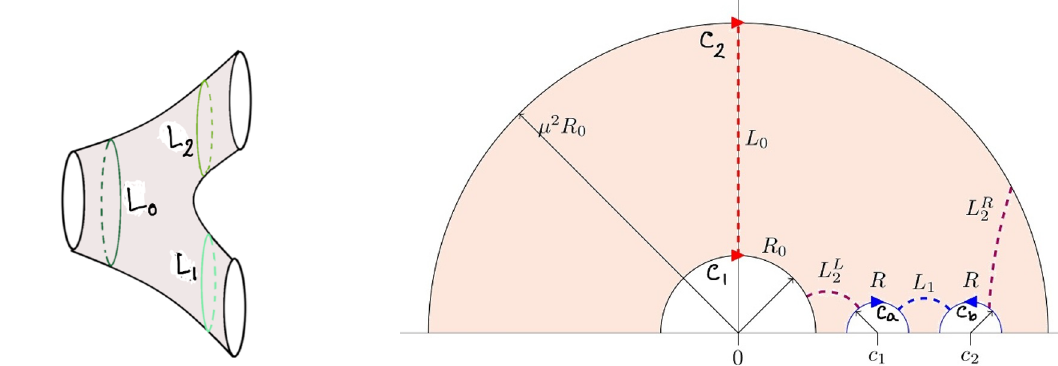
Figure 1. Pair of Pants and Polygonal Representation. In the figure, concentric geodesic edges are denoted by C and C , whereas C and C stand for geodesics that are not concentric. c 1 2 a b c 2 denote the centres of the non-concentric geodesics on the horizontal